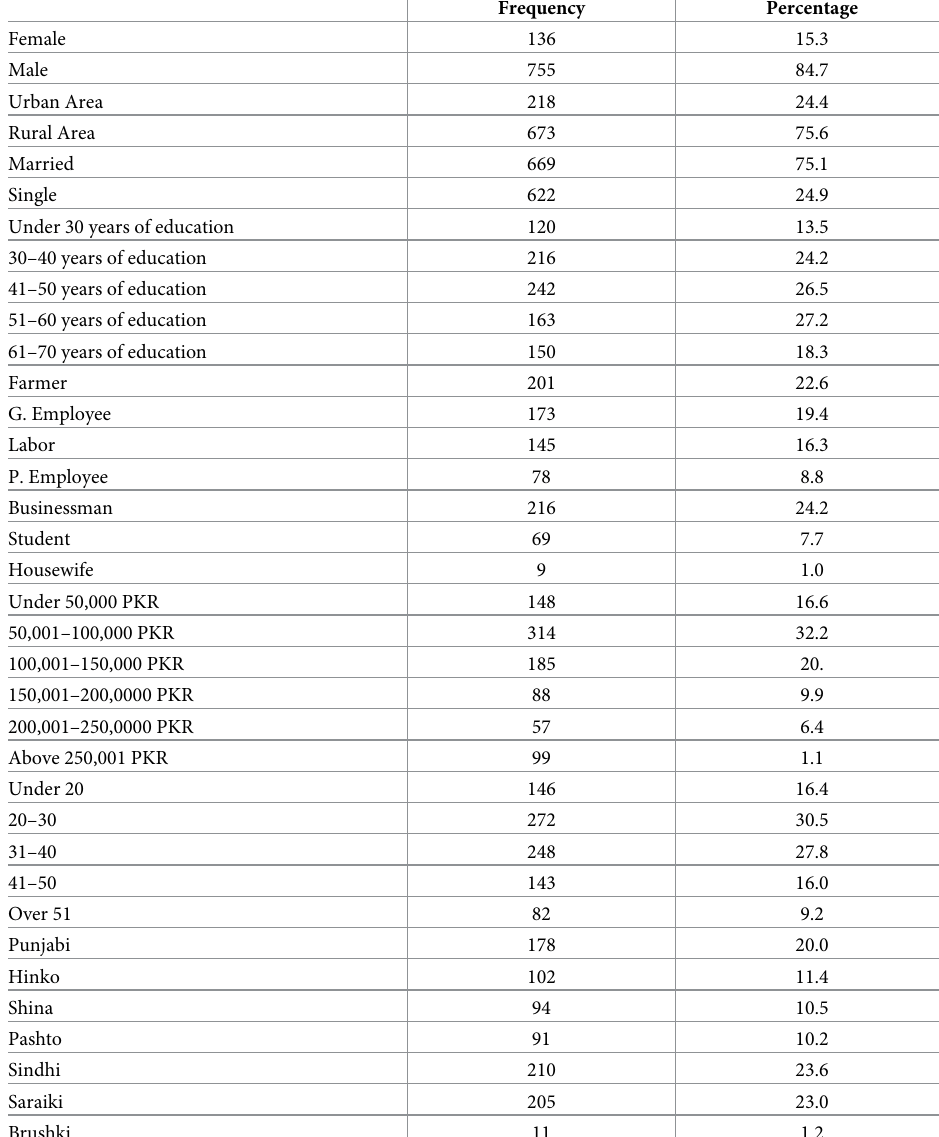
Table 1. Demographic detail of the